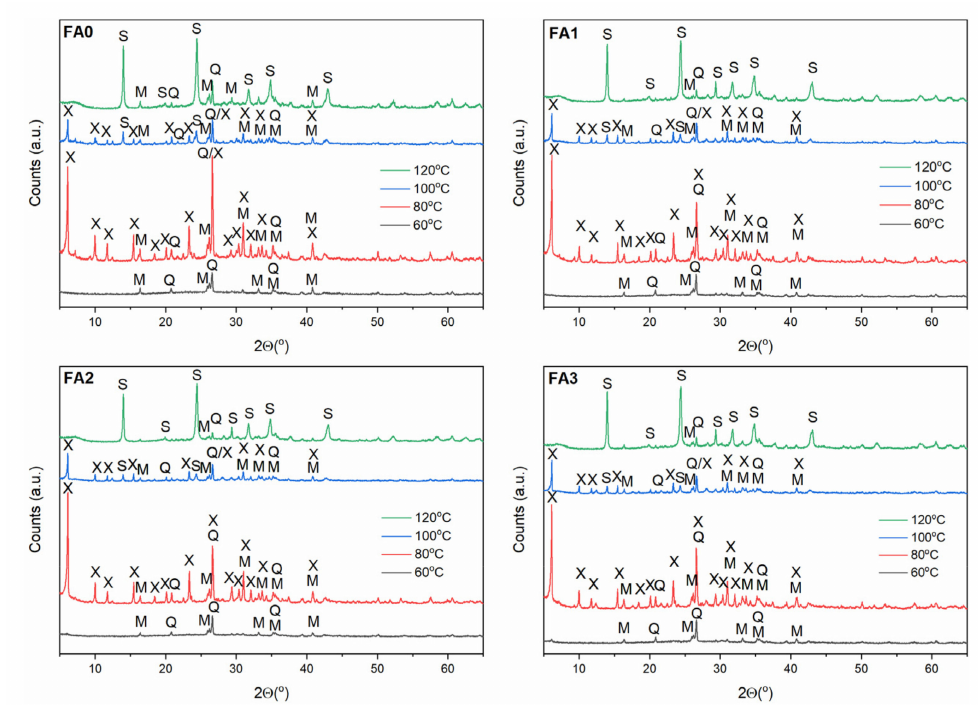
Figure 6. The effect of FA milling and temperature on FA conversion into Na-X zeolite phase.